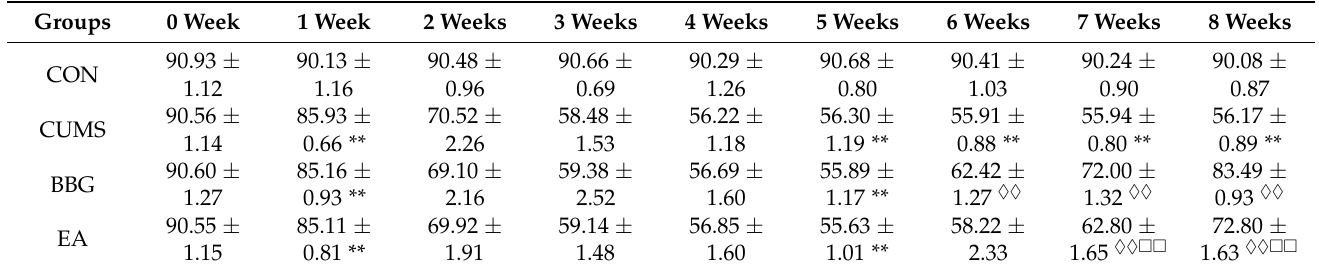
Table 2. Effects of EA on the SPT (n = 10; x ± s; %).